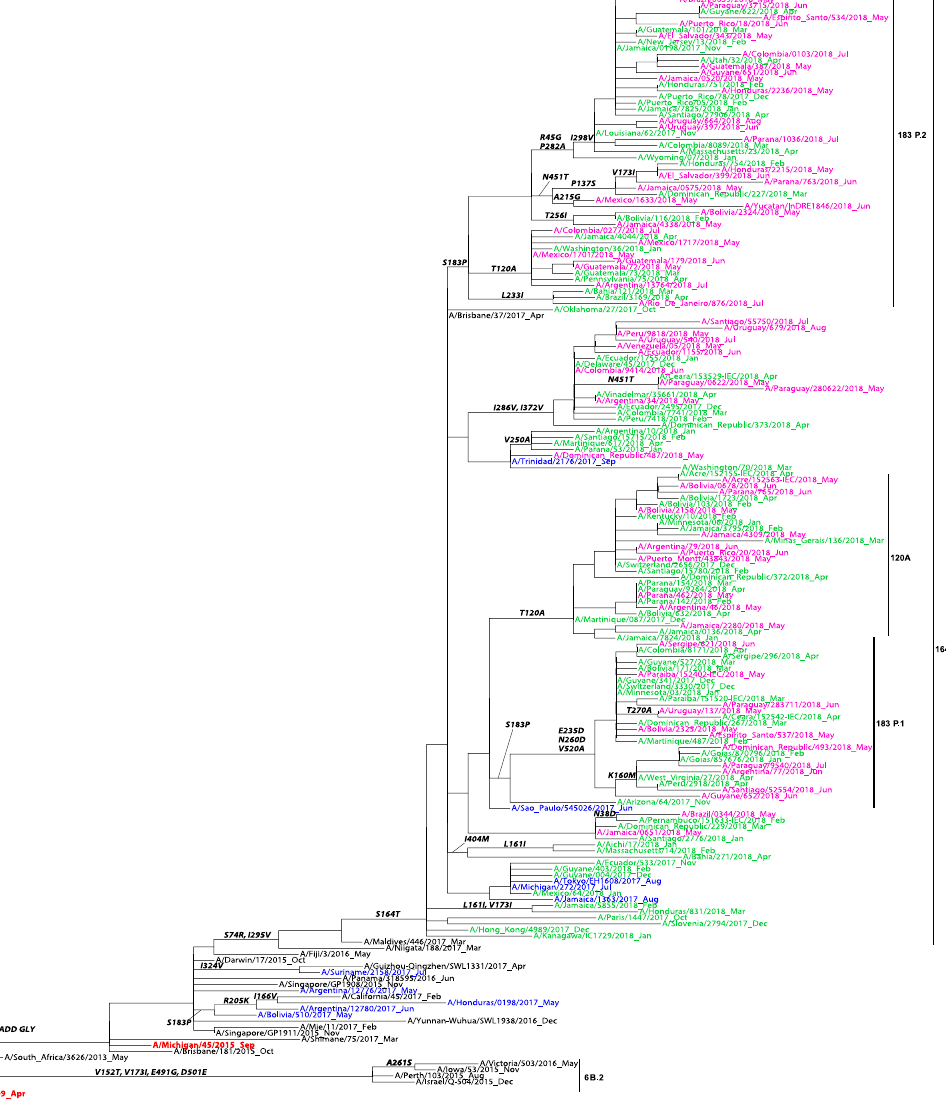
Fig 2. Representative maximum-likelihood tree of n = 139 influenza A (H1N1)pdm09 hemagglutinin (HA) gene sequences from Mexico, South and Central America; sequences from the current and previous vaccine strains (in red) and reference viruses detected worldwide indicated by the CDC WHO CC. HA sequences of influenza viruses collected from May to September 2017 are in blue, October 2017 to April 2018 are in green, May to September 2018 are in pink. Sequences from the time period before the period of analysis, are in black. Amino acid changes and addition (ADD GLY) and loss (LOSS GLY) of glycosylation sites are indicated in bold in the